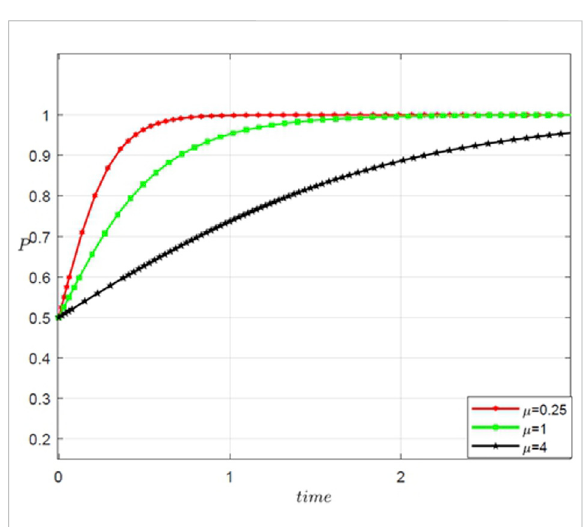
FIGURE 4 The in fl uence of asymmetric ( μ ) on the evolution of